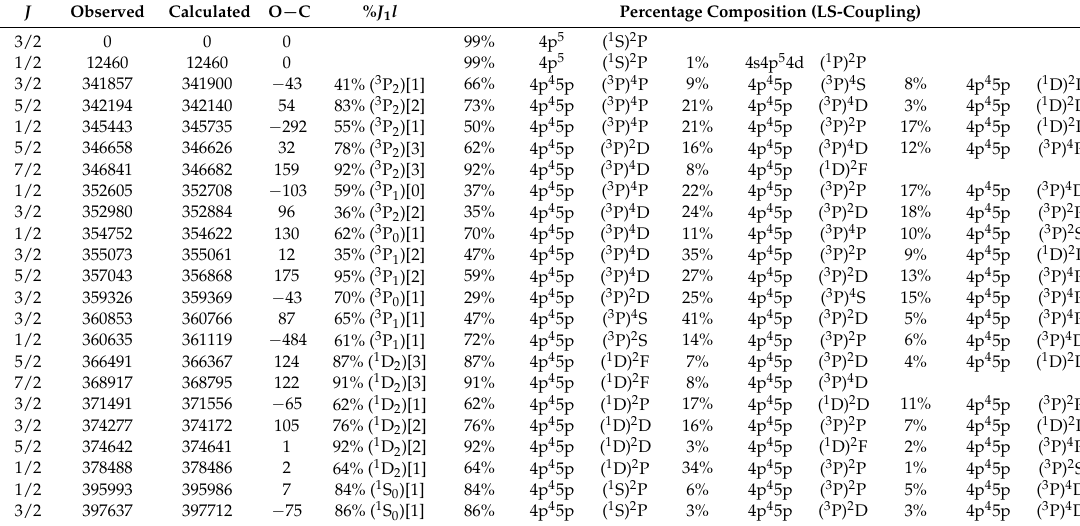
Table 5. Calculated energy levels (cm − 1 ) and percentage compositions for the odd levels of Y